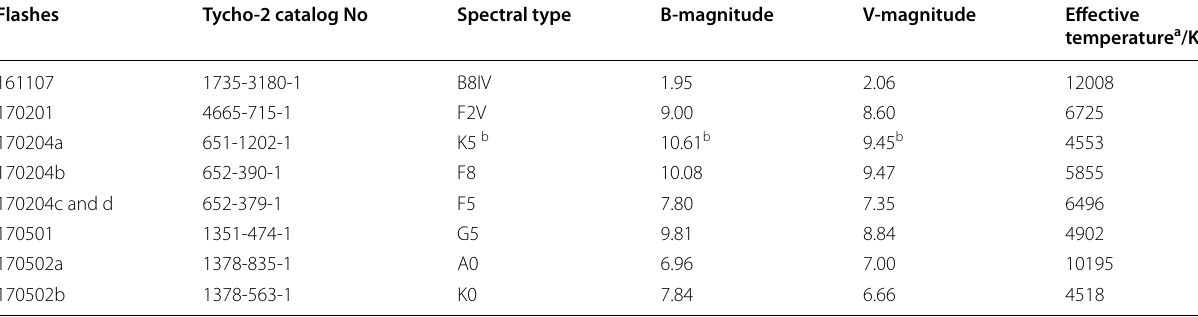
Table 3 Comparison stars for deriving flash spectra